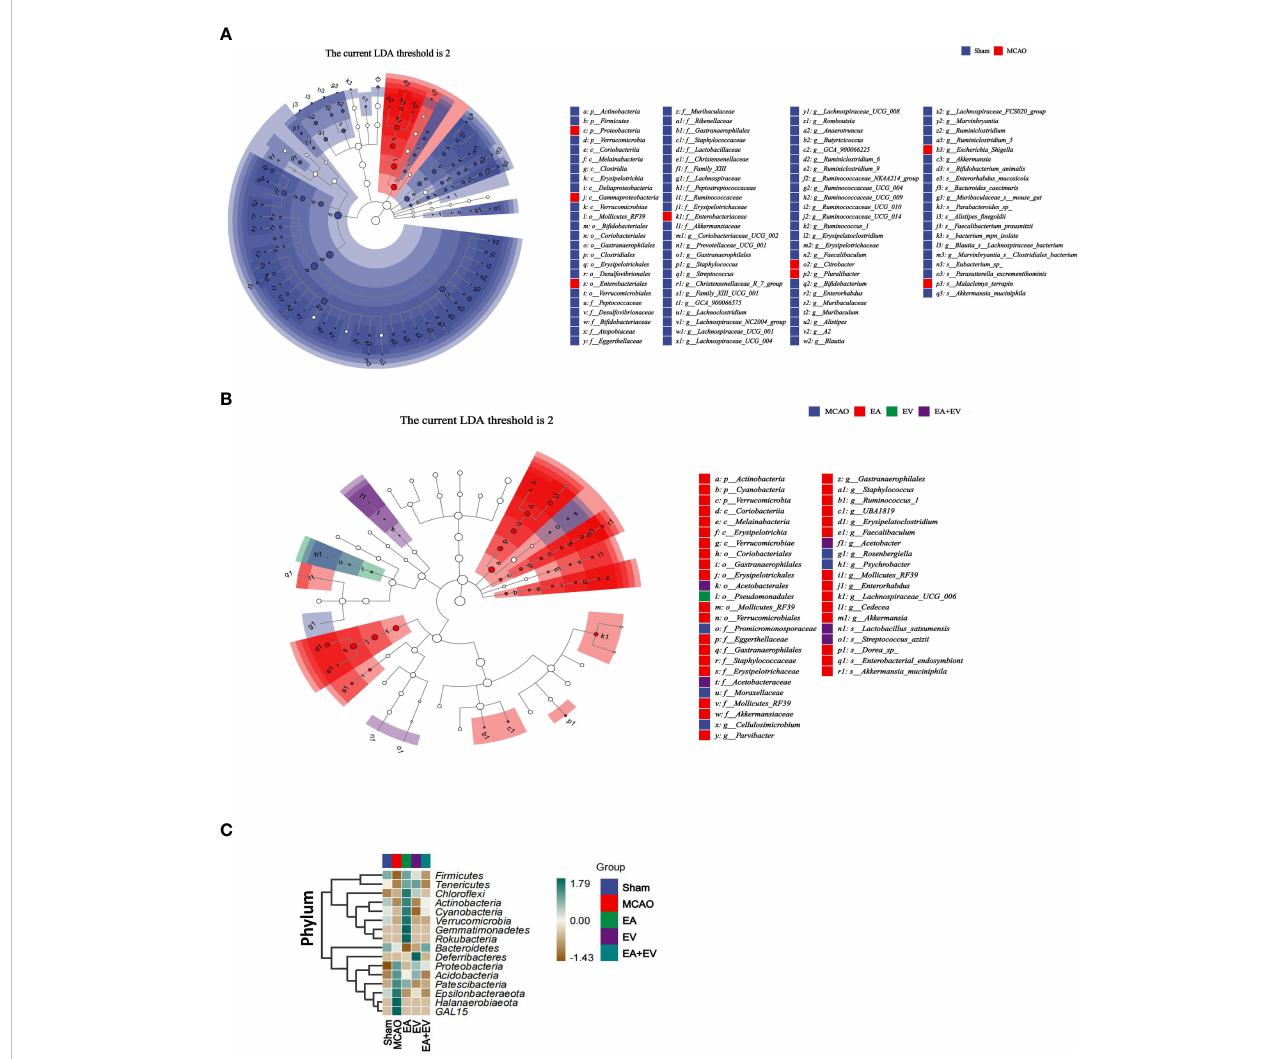
FIGURE 6 EA and iPSC-EVs treatments can regulate microbiota diversity after cerebral ischemia − reperfusion. (A) LEfSe analysis of microbial differences at the species level between the Sham and MCAO groups (B) LEfSe analysis of microbial differences at the species level among MCAO, EA, EV, and EA+EV. The taxonomic cladogram shows the taxonomic hierarchical distribution of marker species in each sample. (C) Heatmap of species composition at the phylum level, n